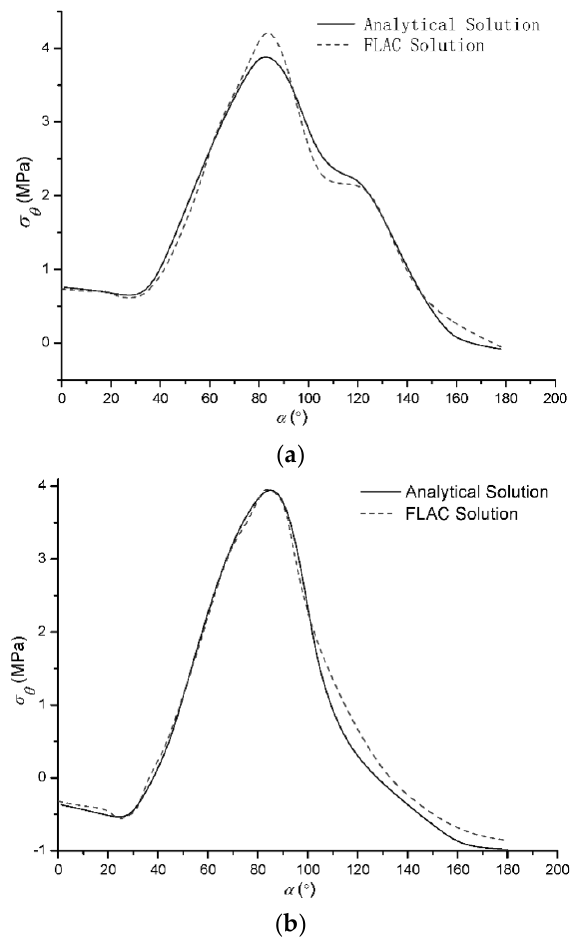
Figure 3. Circumferential stress along the rock – lining interface ( a ) from the lining side ( b ) from the rock side.